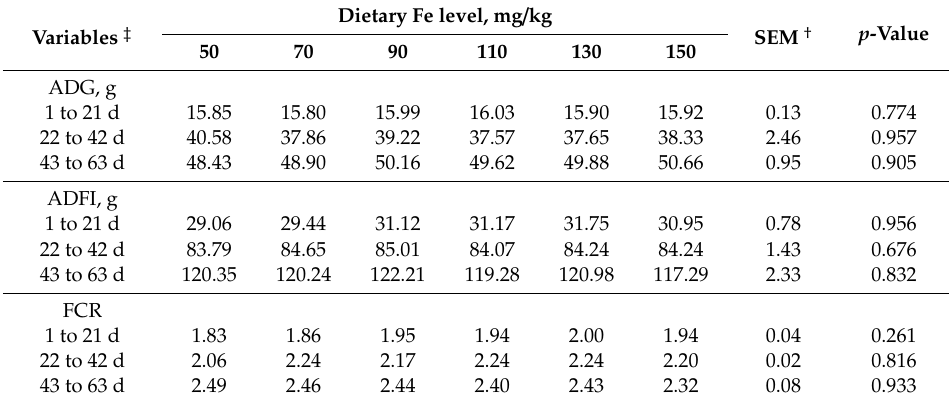
Table 2. E ff ects of dietary Fe on growth performance of Chinese yellow broilers during three 21-d experimental periods.